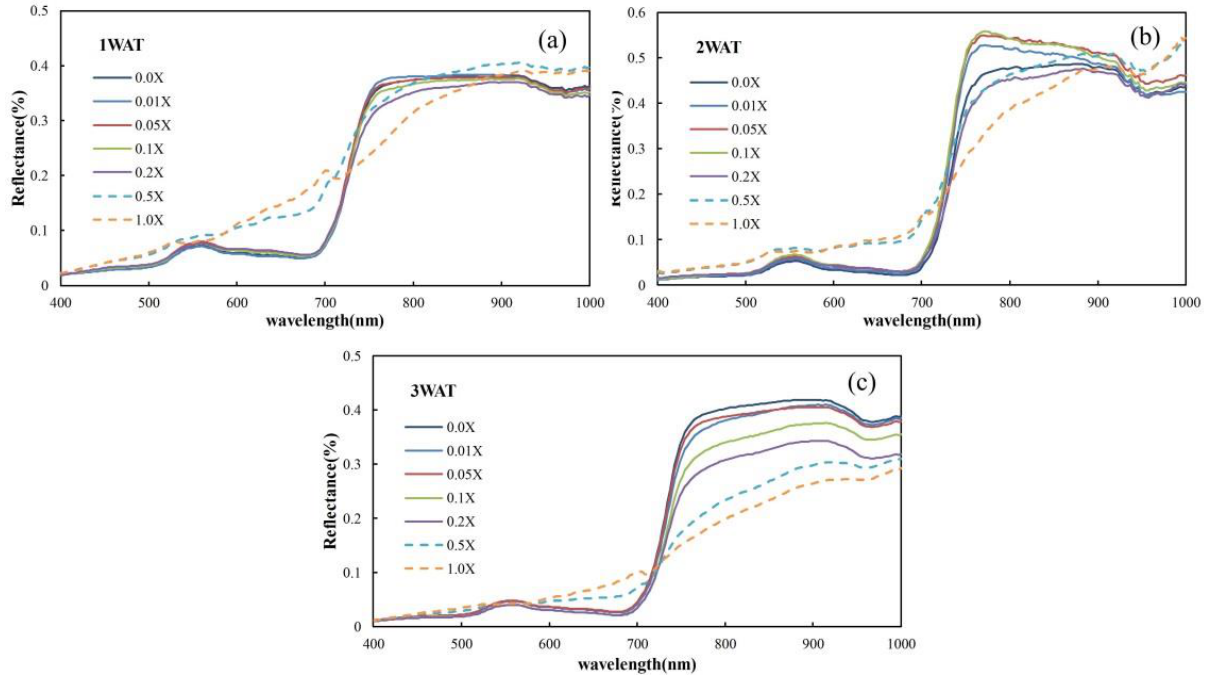
Figure 5. Average reflectance spectral curves at 1 WAT ( a ), 2 WAT ( b ), and 3 WAT ( c ) under different glyphosate rates, where X = 0.866 kilograms acid equivalents/hectare (kg ae/ha) is the recommended application amount per hectare. Table 2. Statistics of the spectral reflectance with different spray rates at different WATs (X = 0.866 kilograms acid equivalents/hectare (kg ae/ha) is the recommended application amount per hec- tare).